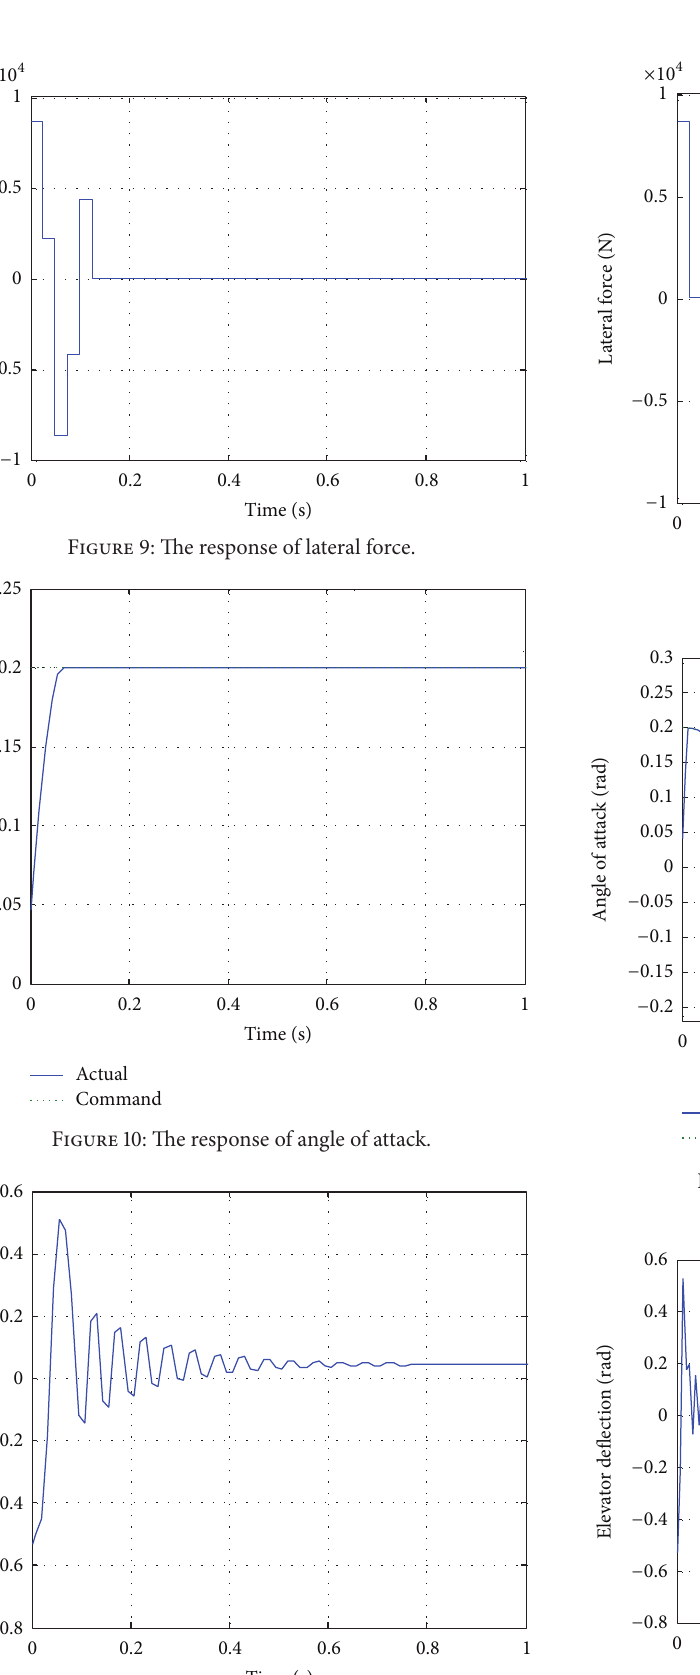
Figure 11: The response of elevator deflection.